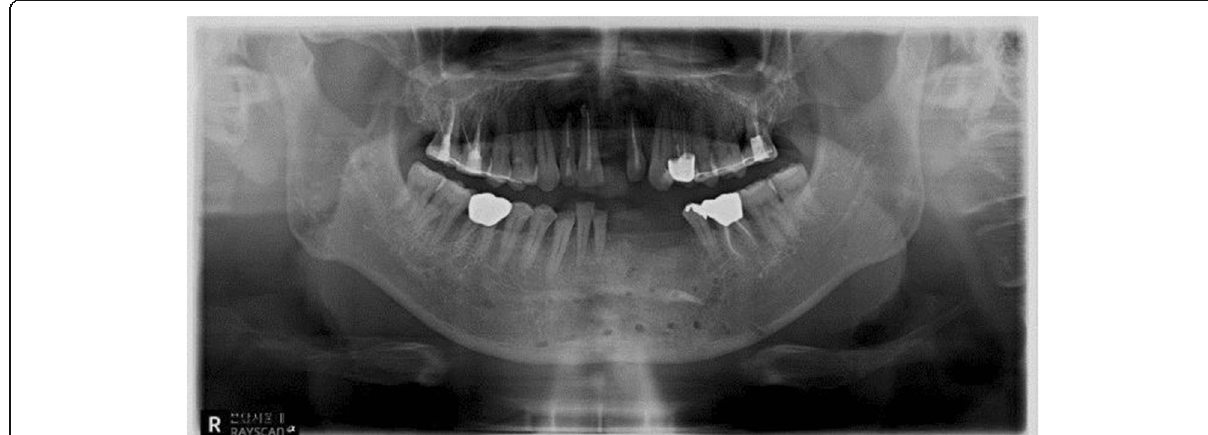
Fig. 6 Postoperative panoramic